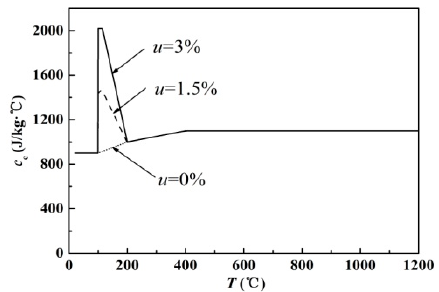
Figure 10. Specific heat of concrete as a function of temperature with different moisture contents.